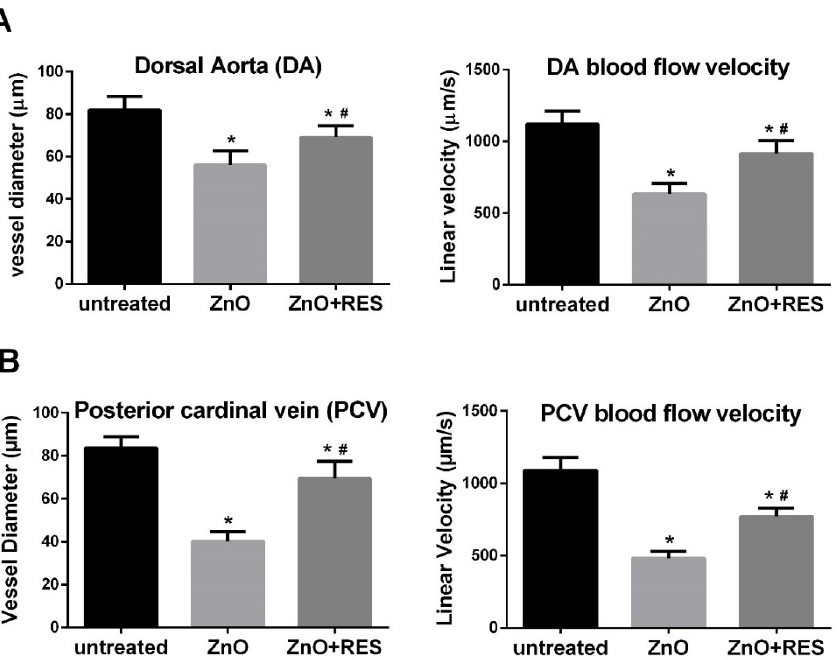
Figure 8. Resveratrol ameliorates cardiac vascular modifications and function induced by ZnO NP. Vessel diameter and blood flow velocity in the two major blood vessels ( A ) dorsal aorta (DA) and ( B ) posterior cardinal vein (PVC) was measured in 96-hpf zebrafish embryos treated with 3 mg/L ZnO NP w/wo 5.0 μM resveratrol. RES, resveratrol. Values are shown as mean ± SD, n = 5. *, significantly different from untreated; #, significantly different from ZnO.